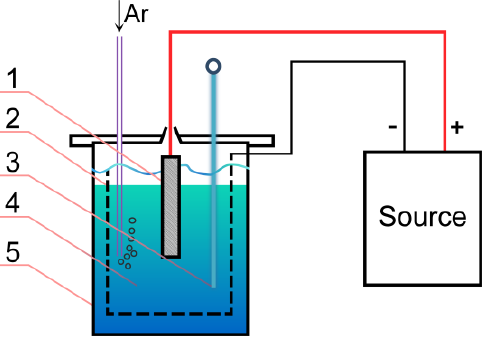
Figure 4. Schematic diagram of inclusion extraction (1 — anode; 2 — cathode; 3 — thermometer; 4 — electrolytes; 5 — beaker). Table 2. Ce content of each sample (mass%).